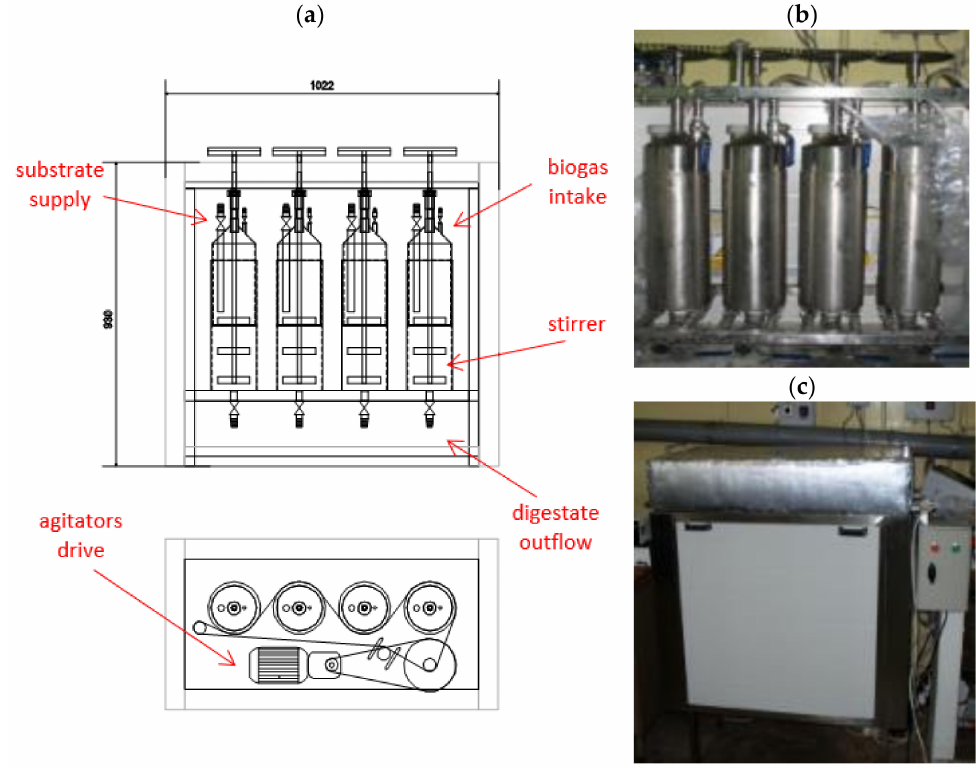
Figure 2. The set of anaerobic reactors used in the experiments: ( a ) technical diagram; ( b ) general view; ( c ) thermally insulated chamber with a heating